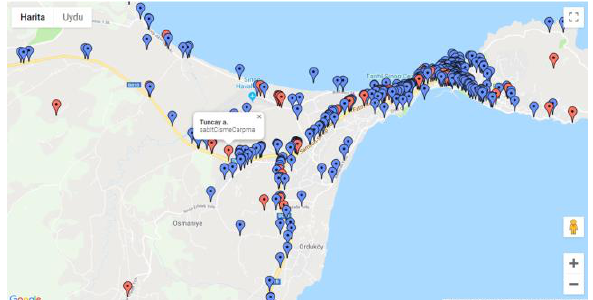
Figure 6. Displaying the actual data and user-entered data on the same